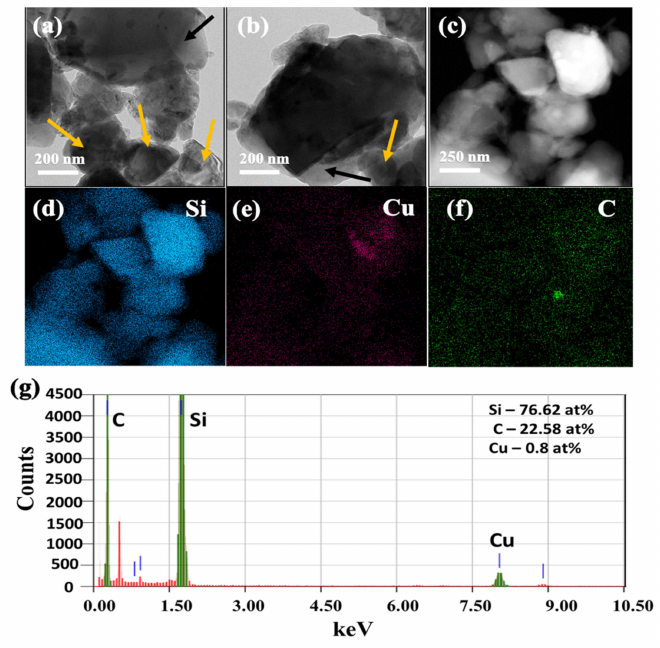
Figure 4. ( a – c ) TEM images, where yellow arrows represent Si particles and black arrows indicate graphite; ( d – f ) corresponding EDX elemental mapping of Si, Cu, and C of ( c ); ( g ) TEM-EDX spectra of SiCuG, where green colored lines indicate C, Si and Cu (from left to right), and red colored lines indicate Copper (Cu) from the TEM sample